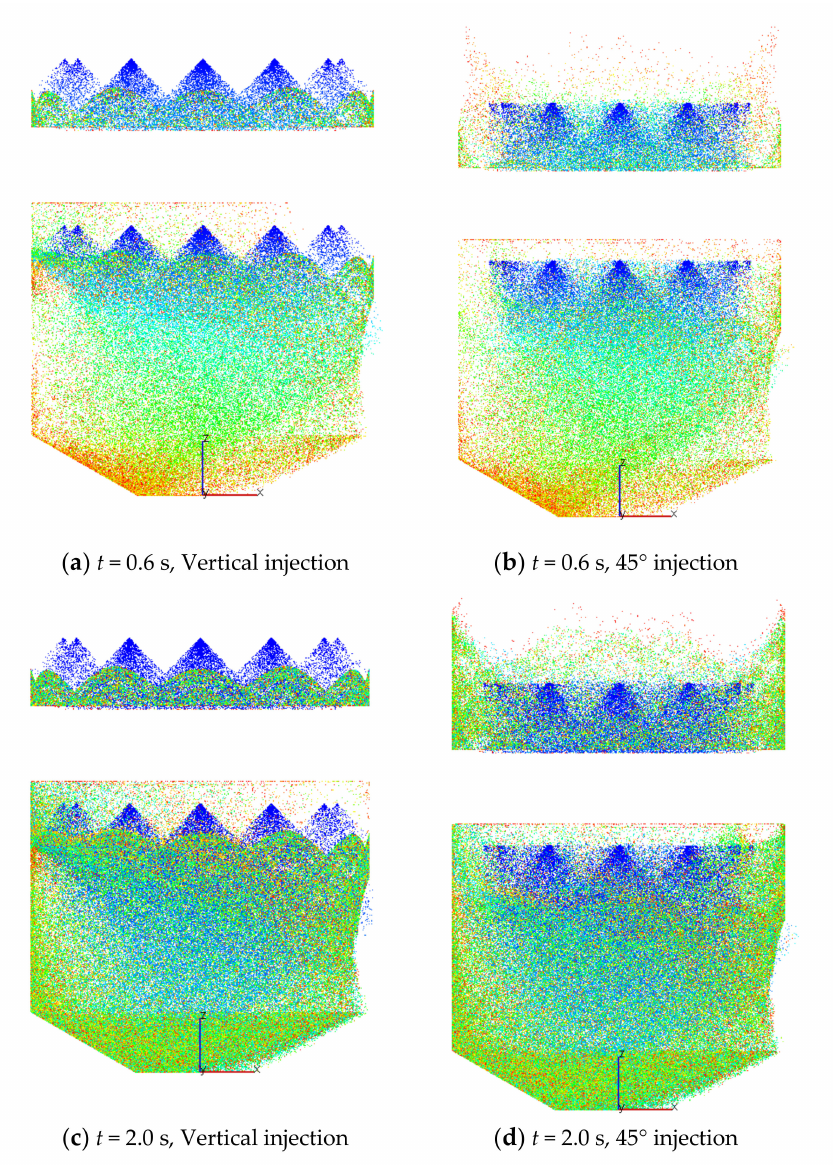
Figure 20. 3D distribution of the